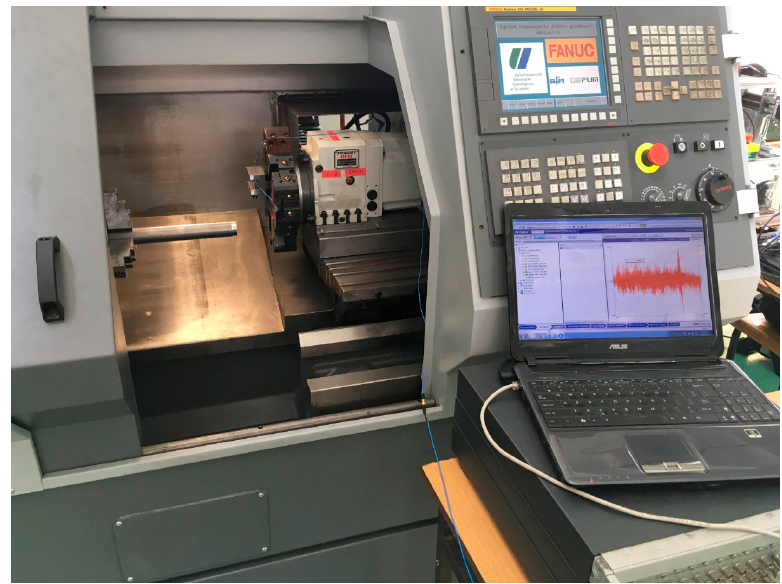
Figure 7. Experimental stand–TAE 35N.